Question: Summarize what this figure shows in one sentence.
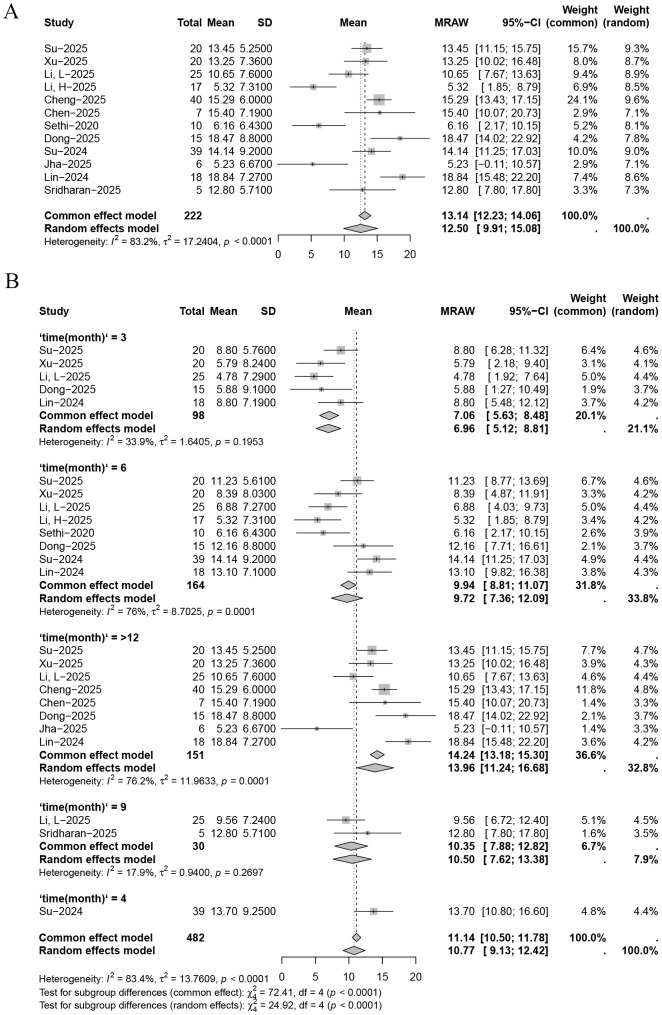
Answer: (A) Forest plot of serum albumin; (B) Forest plot of the subgroup analysis of follow-up time for serum albumin.